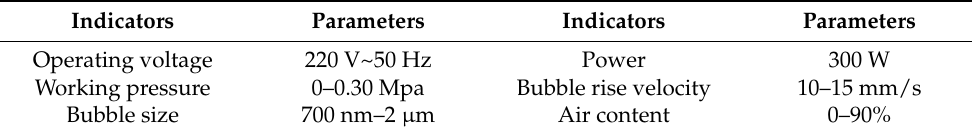
Table A1. Main technical parameters of the micro–nano generator.